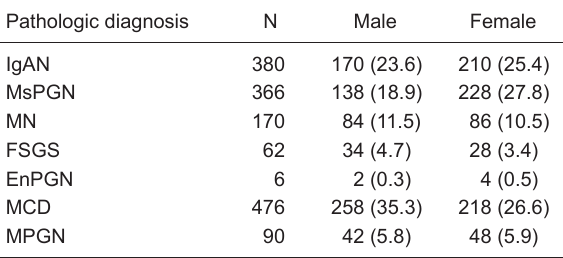
Table 2. Gender distribution of primary glomerular